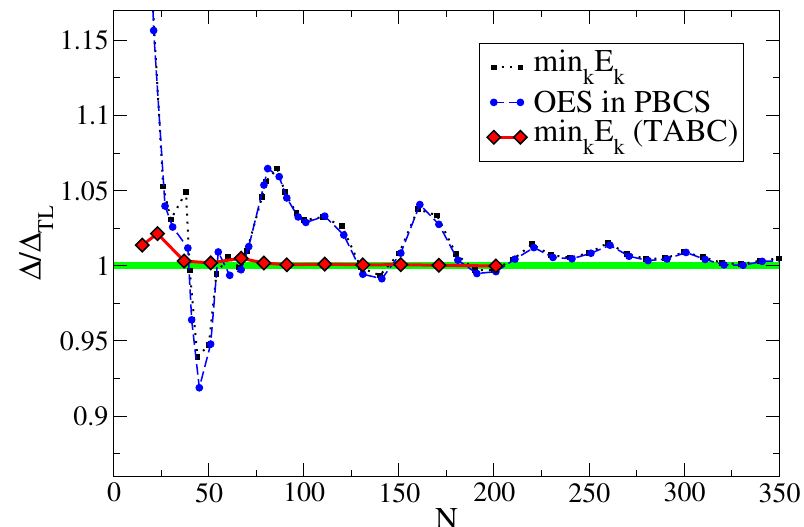
Figure 3. The minimum of the quasi particle excitation energy and the odd–even staggering (OES) in the projected Bardeen–Cooper–Schrieffer (PBCS) theory under periodic boundary conditions (PBCs) for k F a = − 10. The minimum of quasiparticle excitation energy under twist-averaged boundary conditions (TABCs) is shown in